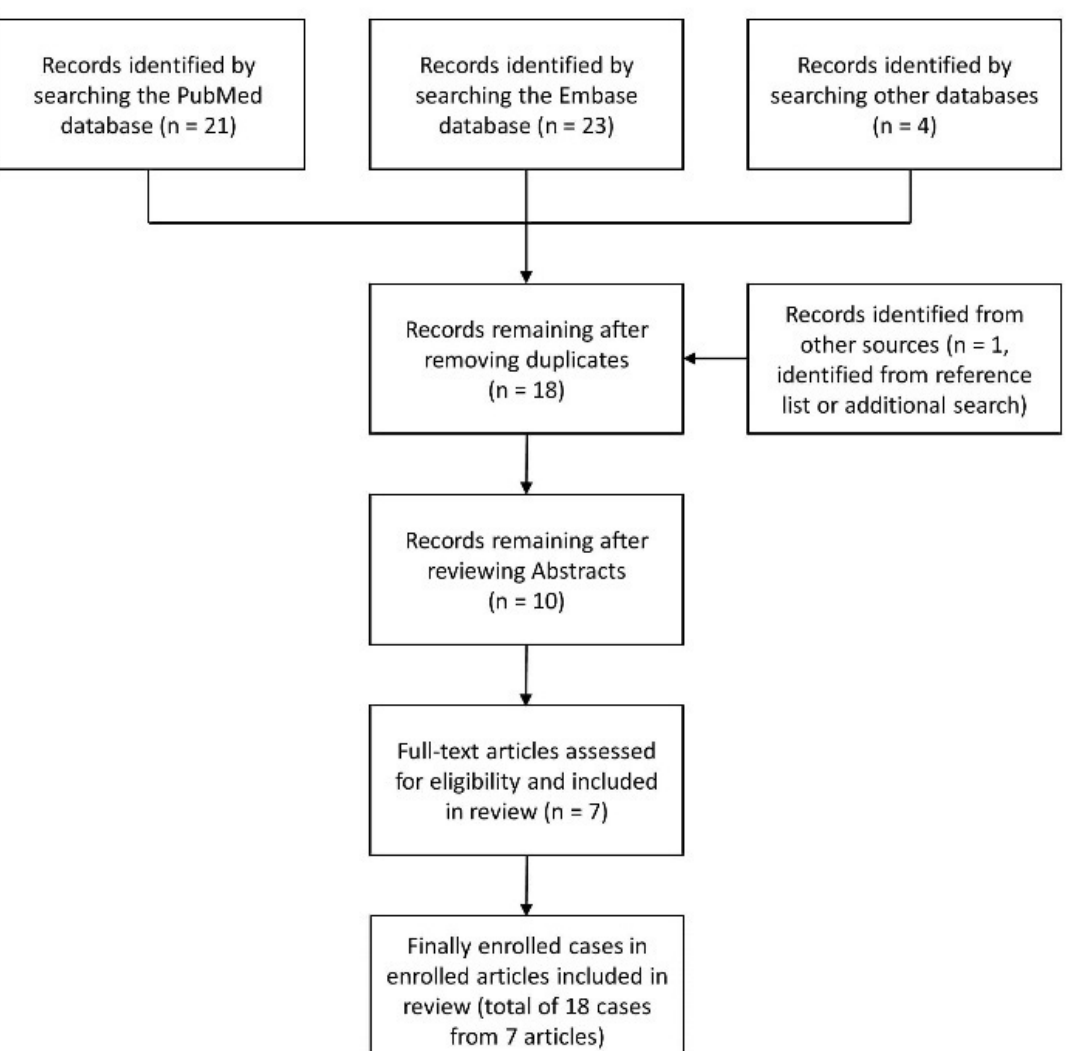
Figure 1. Flow diagram demonstrating the inclusion/exclusion process for studies included in the final analyses.